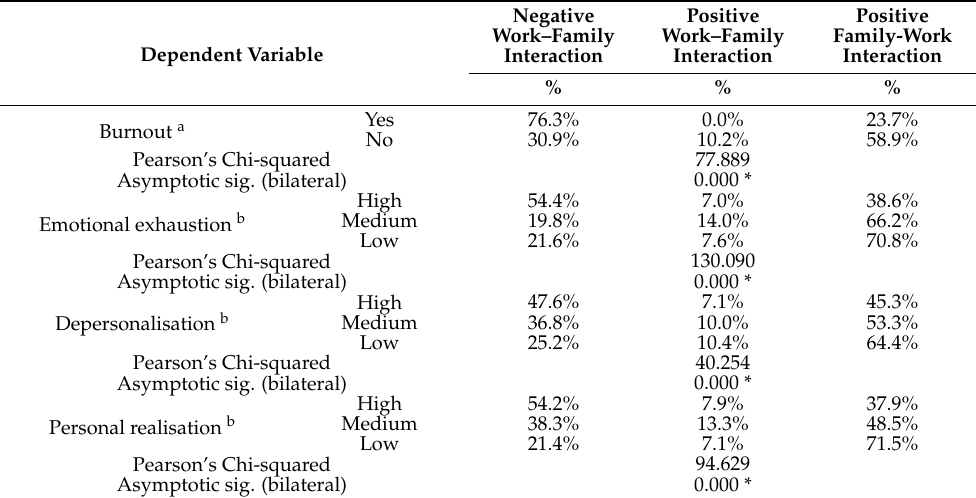
Table 3. Group statistics and Pearson’s Chi-squared test for burnout and its dimensions with the dimensions of